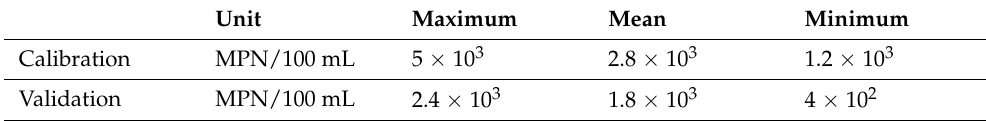
Table 4. The maximum, minimum, and mean concentration of FC in seawater at Buenaventura Bay during the calibration and validation